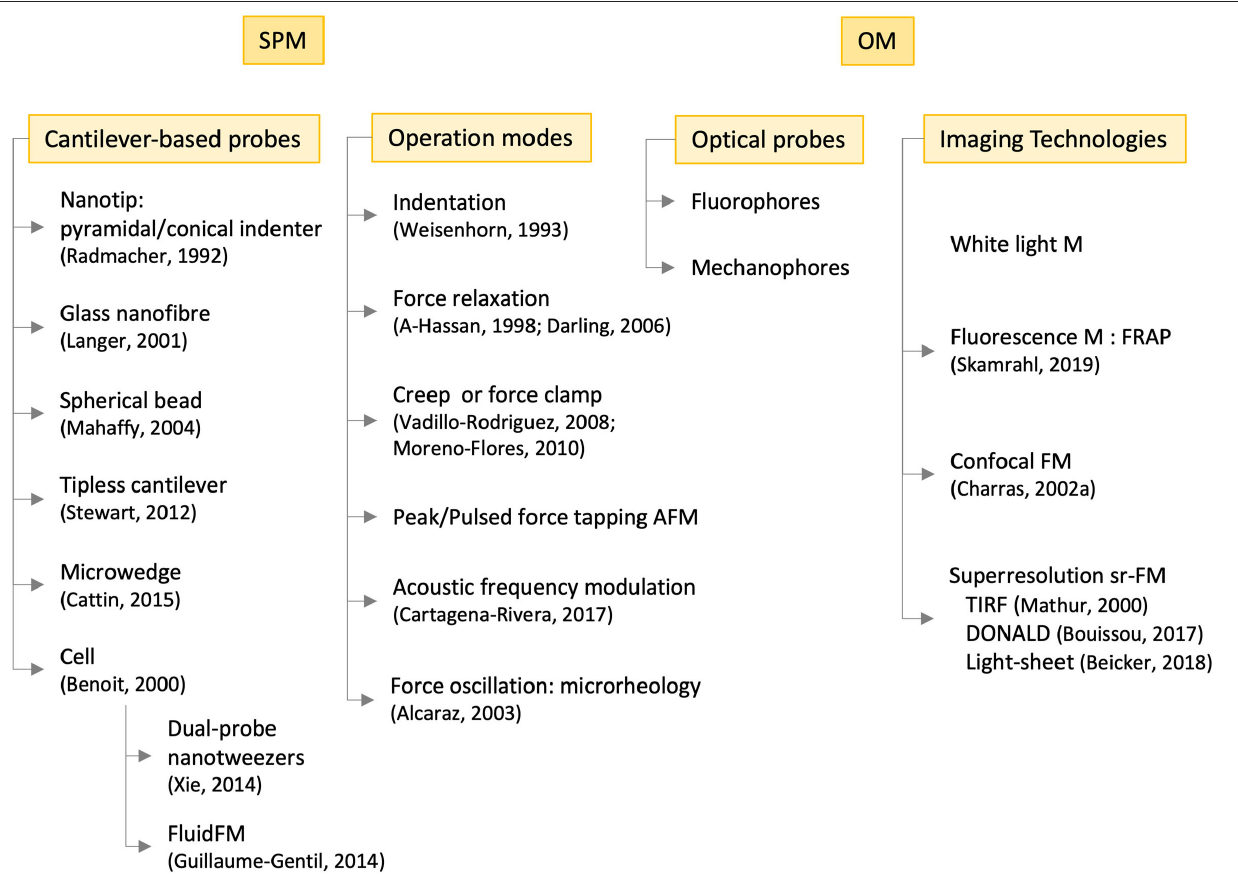
FIGURE 9 | Operational modes and technologies employed in the experimental study of cell mechanics with scanning probe microscopies (SPM, left-hand side) and optical microscopies (OM, right-hand side), the latter in combination with the former. Some references are included of pioneering or outstanding works. M, microscopy; F, fluorescence; FRAP, fluorescence recovery after photobleaching; TIRF, total internal reflection fluorescence; DONALD, direct optical nanoscopy with axially localized detection; sr,